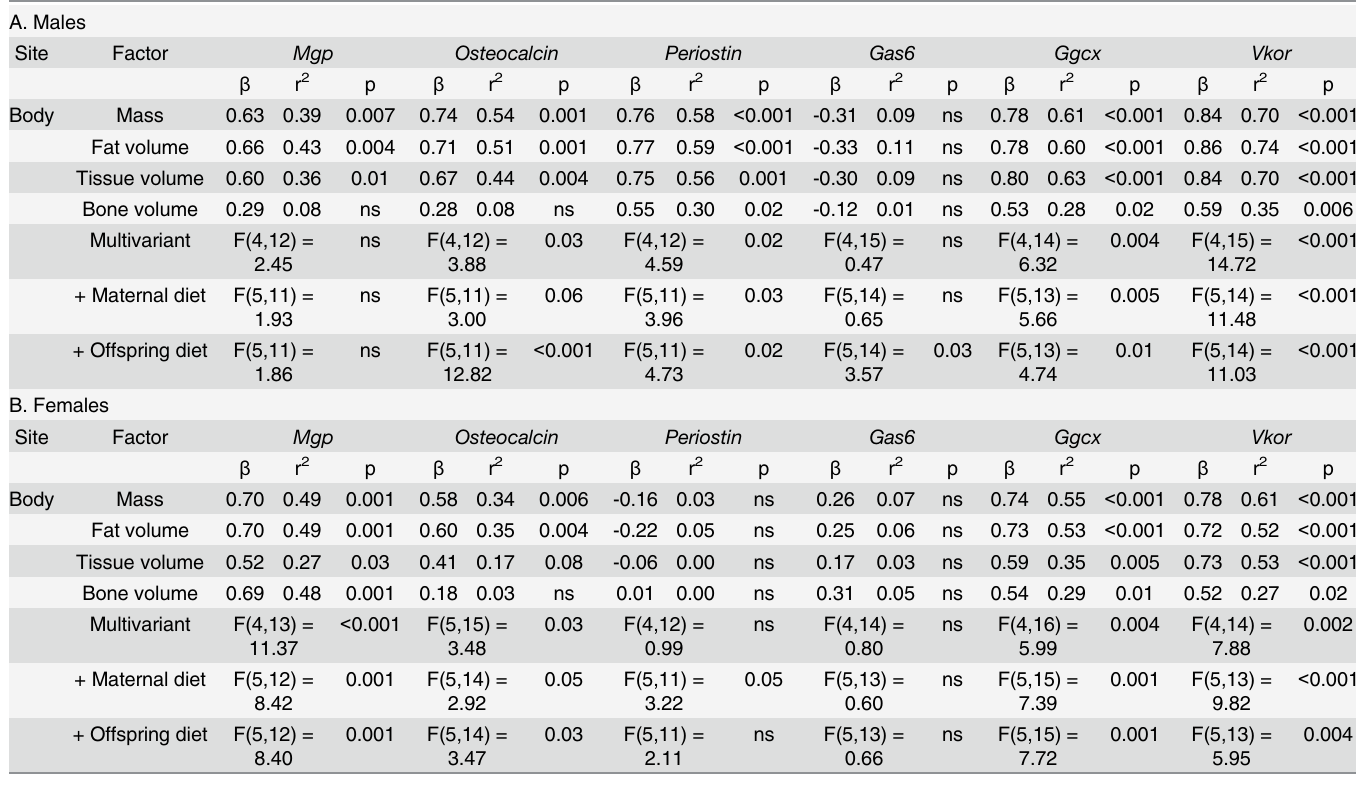
Table 1. Linear regression analysis between femoral vitamin K-dependent protein expression levels and body